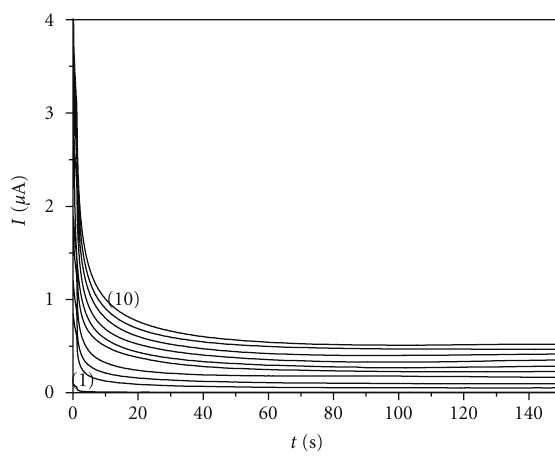
Figure 5: Chronoamperograms. E ff ect of ASA concentration at one potential level, +0.9 V versus SCE, around the corresponding current peak potential from CVs. (1) supporting electrolyte, (2) 0.01mM, (3) 0.02mM, (4) 0.03mM, (5) 0.04mM, (6) 0.05mM, (7) 0.06mM, (8) 0.07mM, (9) 0.08mM, (10) 0.09mM; supporting electrolyte: 0.1 M Na 2 SO 4 pH 7.